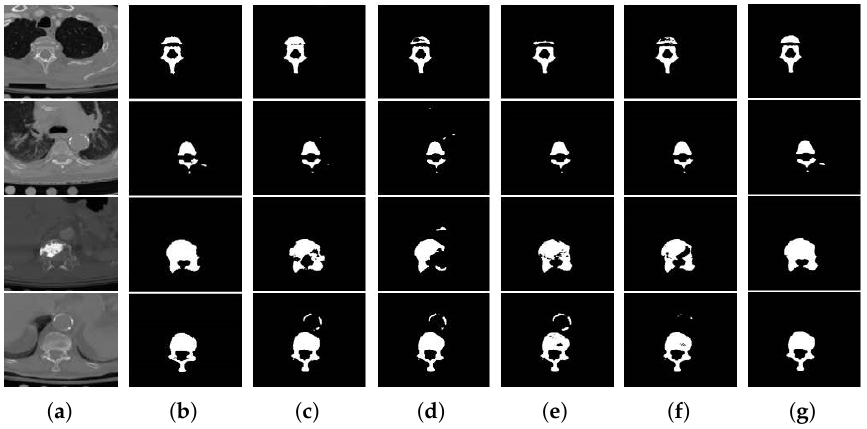
Figure 5. Visual comparison. ( a ) Original image. ( b ) Ground truth. ( c ) SegNet. ( d ) AU-Net. ( e ) U-Net. ( f ) U-Net++. ( g )